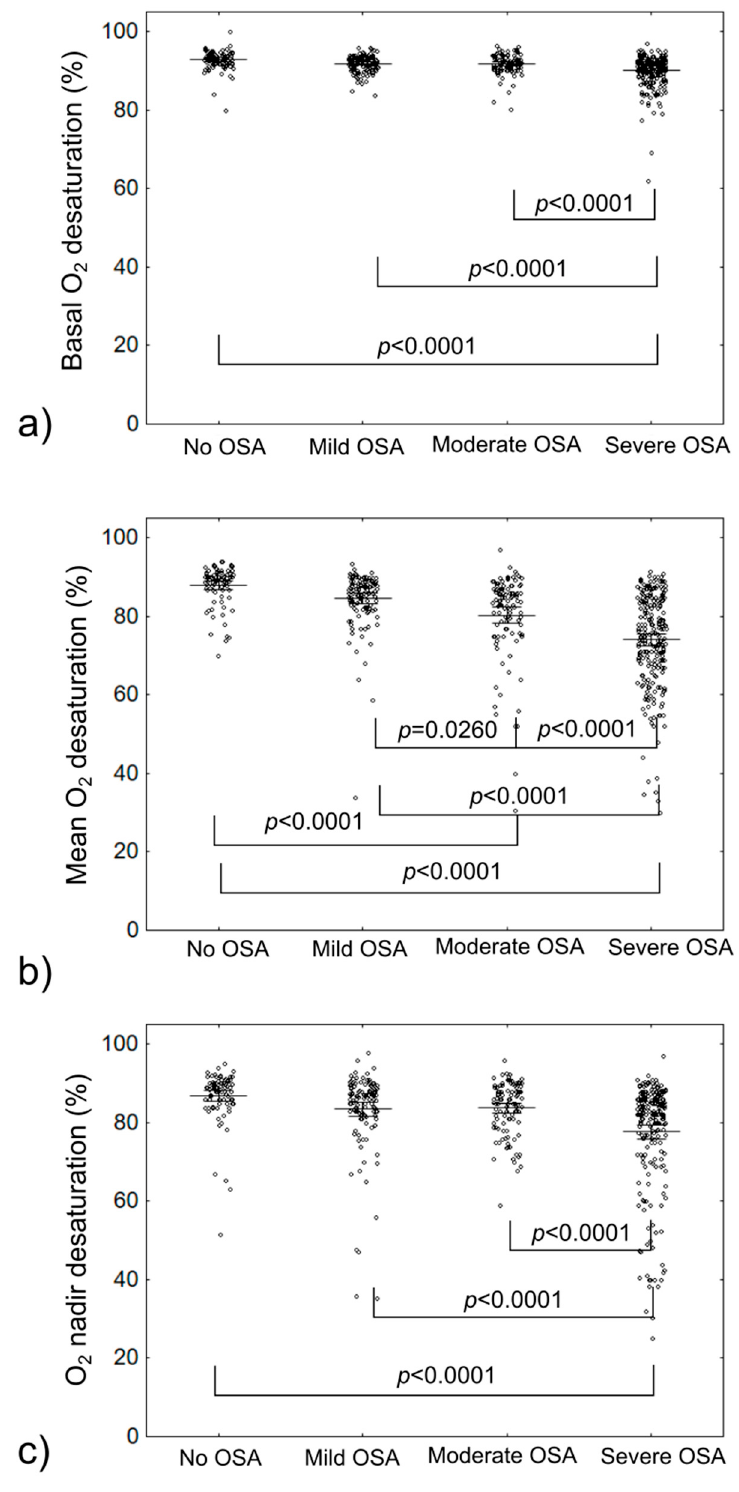
Figure 1. Comparison of O 2 saturation parameters in different OSA severity groups; ( a )—based on basal O 2 saturation; ( b )—based on Mean O 2 desaturation; ( c )—based on O 2 nadir desaturation; OSA—obstructive sleep apnea.